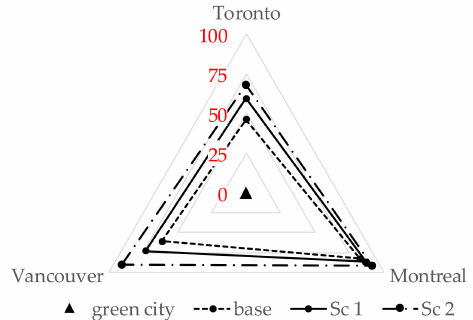
Figure 3. Normalized ratio of impervious area to the city area (water bodies excluded) for Toronto, Montreal, and